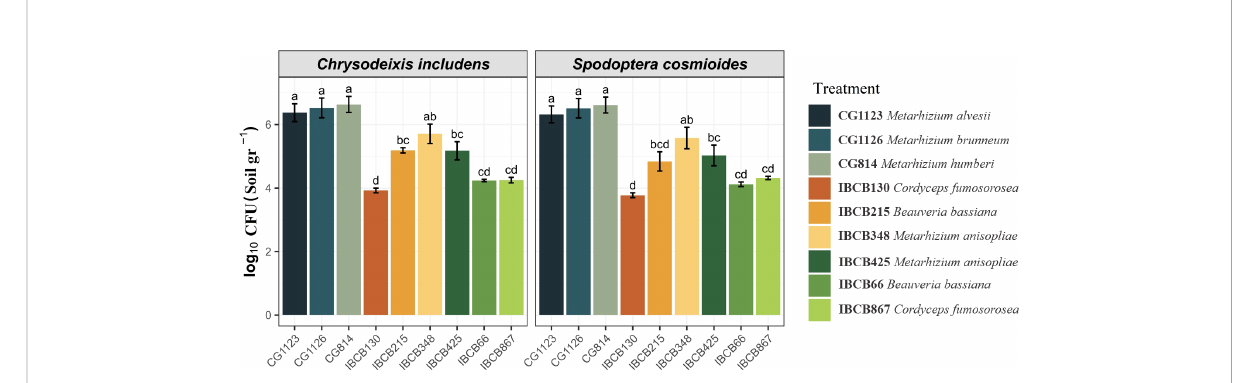
FIGURE 2 Presence of entomopathogenic fungi in CFU/g soil on peanut plants 30 days after